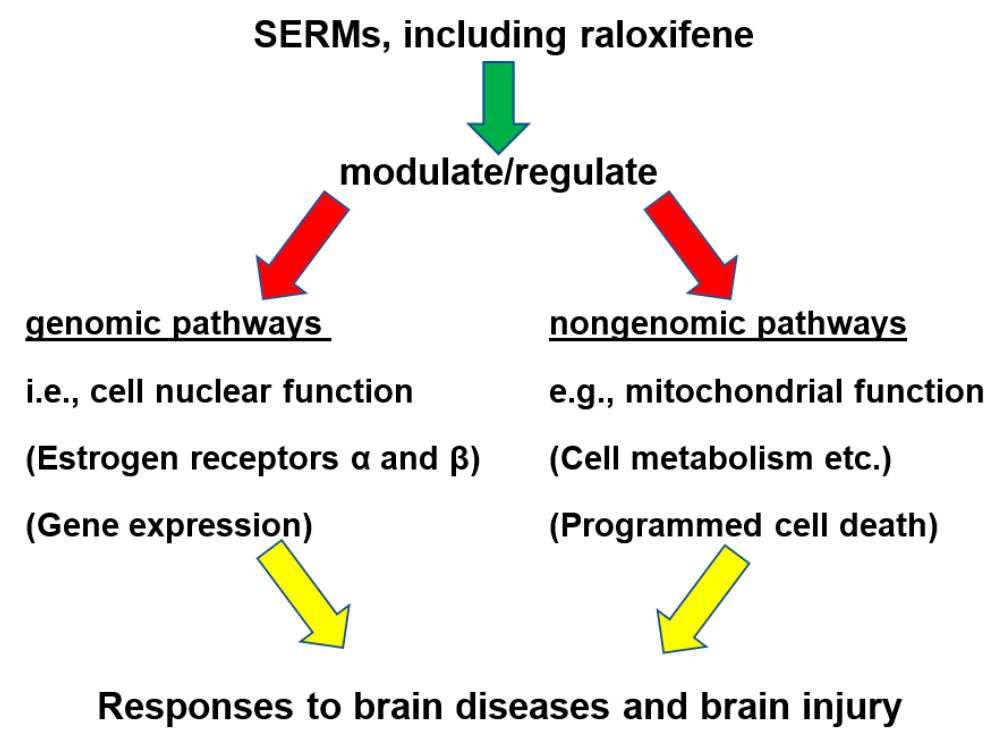
Figure 3. A generalized scheme of pathways, whereby SERMs, including raloxifene, may provide neuroprotection and curation in response to brain disease and brain injury. This is excerpted from the notion that SERMs, including raloxifene, appear to simultaneously affect genomic and nongenomic functions, i.e., cell nuclear function via the estrogenic receptors ER α and ER β , modulating gene expression (genomic), while the various nongenomic functions include, but are not restricted to, interaction with the cell plasma membrane estrogen receptor (GPER), mitochondrial functions, cell metabolism, programmed cell death, as well as various others (e.g., [73,74,78,79]).